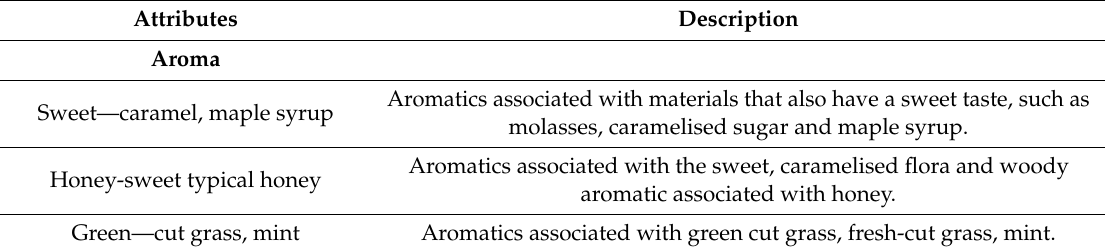
Table 1. Descriptions of sensory attributes of